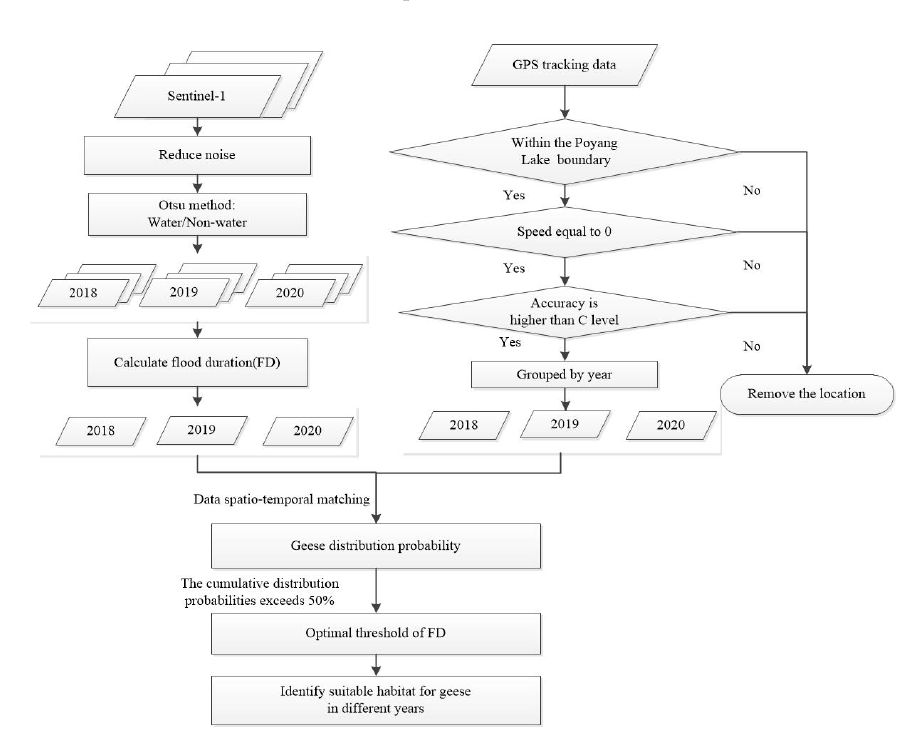
Figure 3. Method workflow.